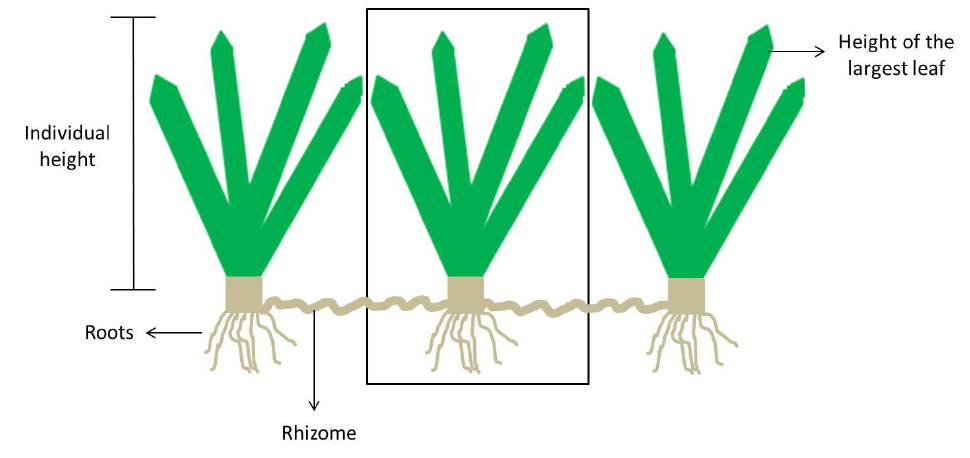
Figure 1. Scheme showing the emergent aquatic macrophyte Crinum americanum forming rosettes.